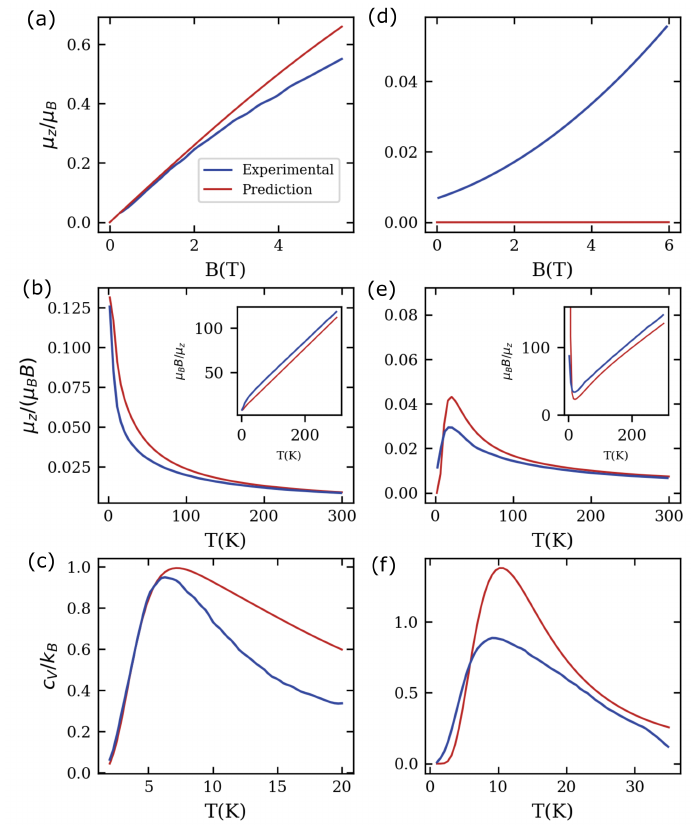
Figure 9: CNN application to PrAgSb mental data (blue) and CNN predictions (red) for input data { µ Experimental data is from Refs. [ 29,31 ] . Theory results are calculations (within the single-ion approximation ) using the CF parameter values { ˆ x (see Tab. 2 and 3). We find good agreement between experimental data and CNN predictions with a MSE = 0.074 (PrAgSb that due to the lack of experimental data containing information about the magnetic anisotropy, the parameters x properly learned by the CNN. Also note the small y axis scale in panel (d) due to a strong ab easy-plane